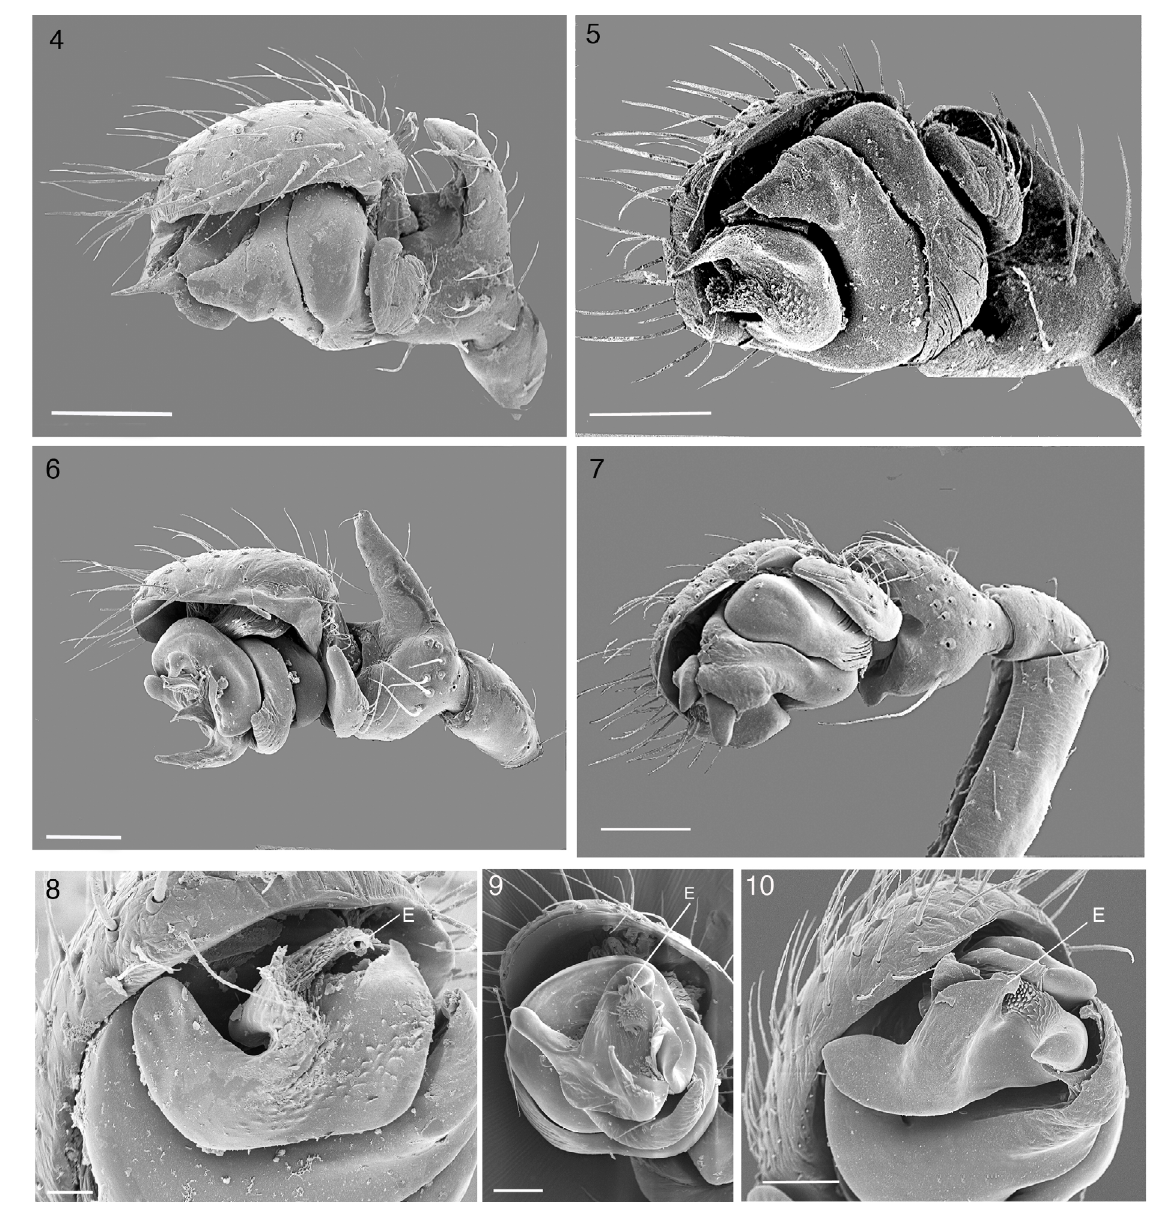
Figs 4-10. SEM micrographs. — 4-5, 8 . Holmelgonia afromontana sp. nov. (♂, MRAC 227153). 4 . Palp, retrolateral view. 5 . As previous, ventral view. 8 . Embolic division, frontal view. — 6, 9 . Holmelgonia bosnasutus sp. nov. (♂, MRAC 227145). 6 . Palp, retrolateral view. 9 . Embolic division, ventral view. — 7, 10 . Holmelgonia disconveniens sp. nov. (♂, MRAC 241448). 7 . Palp, retrolateral view. 10 . Embolic division, frontal view. Scale bars 4-7 = 100 μm; 9-10 = 50 μm; 8 = 20 μm. E: